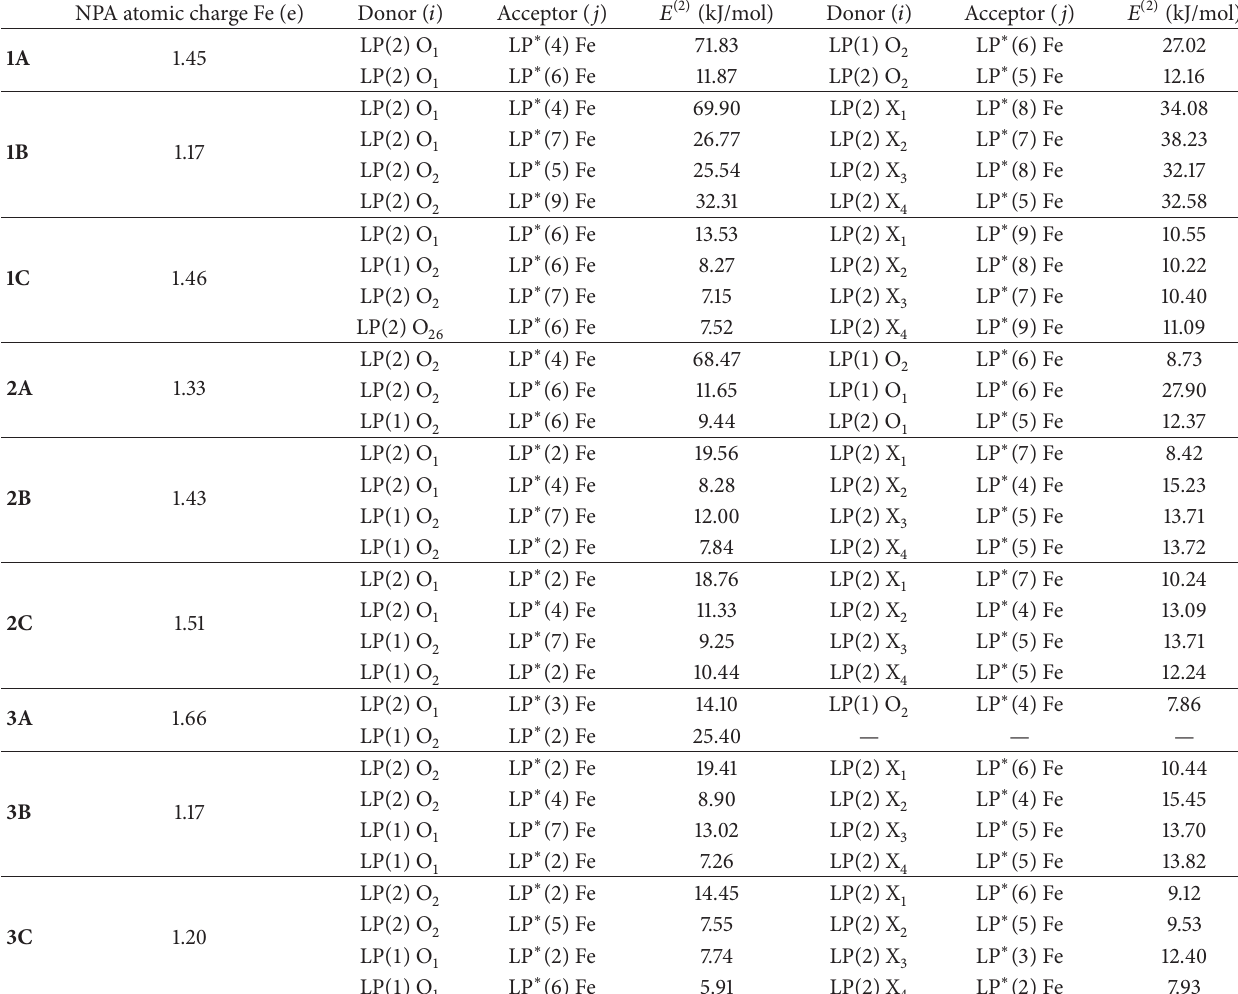
Table 5: NBO analysis of the metal-ligand bonds and NPA atomic charge of the central Fe in the chelates and complexes obtained